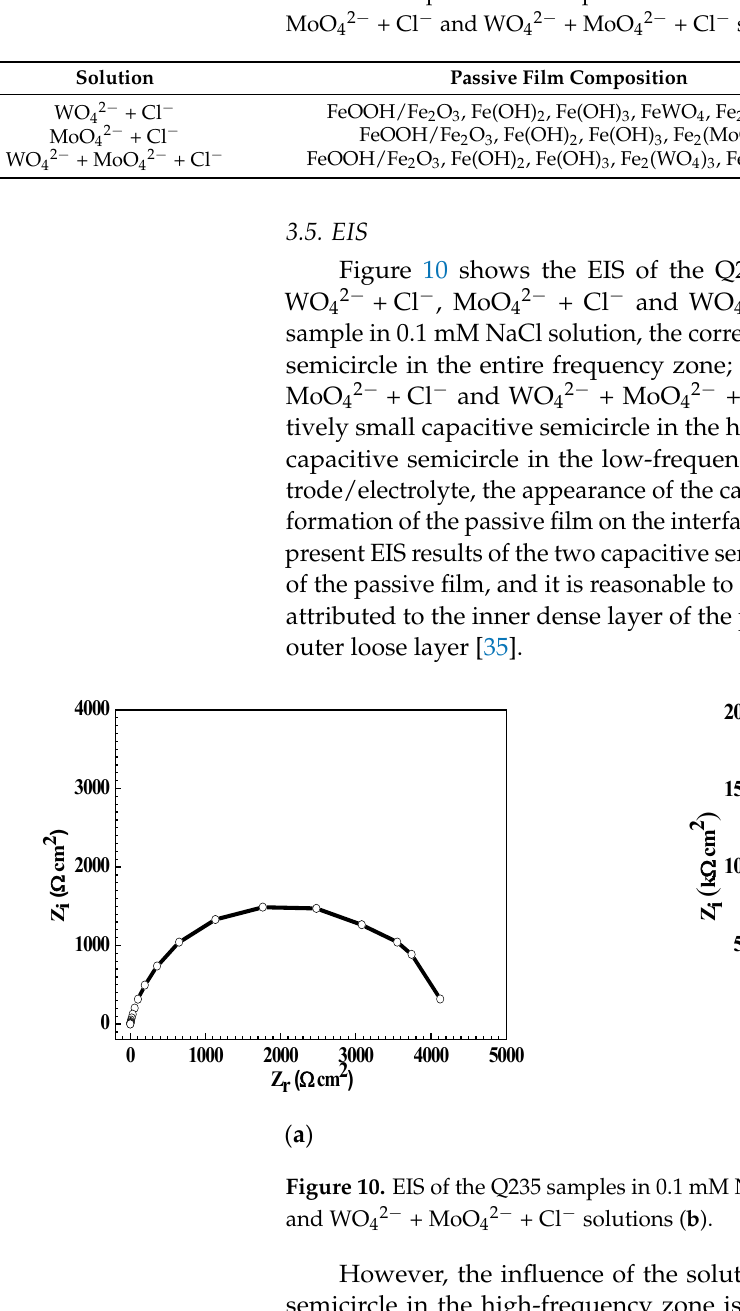
Table 3. Composition of the passive film on Q235 carbon steel surface formed in WO 4 2− + Cl − , MoO 4 2− + Cl − and WO 4 2− + MoO 4 2− + Cl − solutions.